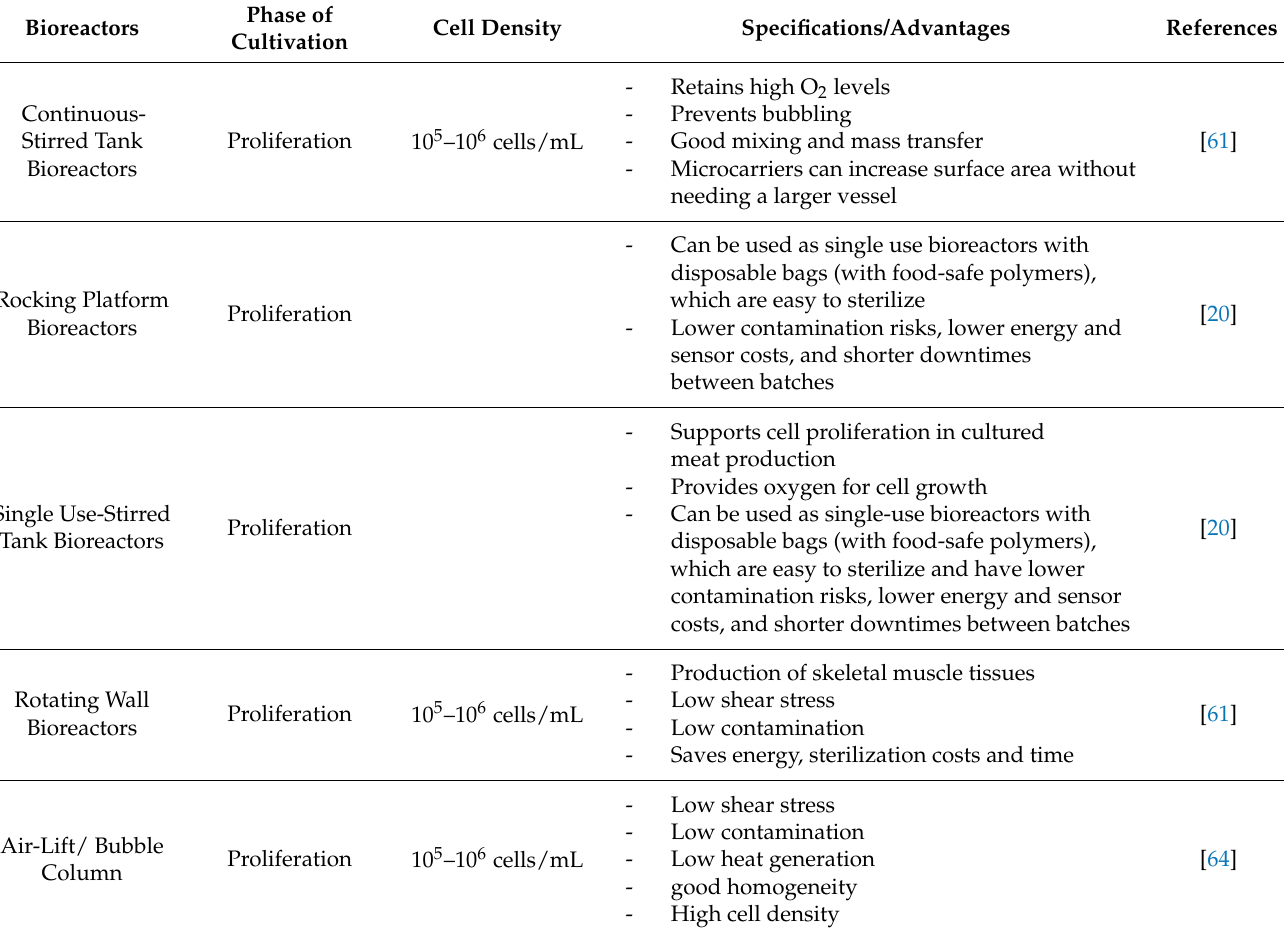
Table 2. Different types of bioreactors used to produce cultured